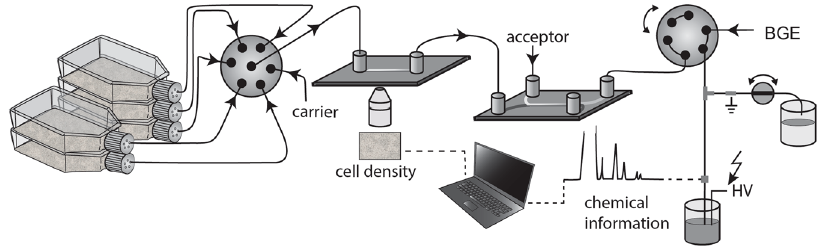
Figure 1. Schematic diagram of the experimental setup. Sample is sequentionally withdrawn from one of the five culture flasks, controlled by the selector valve. A carrier (5% methanol) is used to rinse to prevent cross contamination between samples. Digital imaging for cell density measurement is done using automated image analysis. The sample is then transported to a H-filter, where analytes are extracted into a cell-free solution, which is analysed by SI-CE with C4D. Fluidic isolation provided by the six port valve allows cell density measurement and extraction during the CE separation of the previous sample. With a run time of 12 minutes each flask is sampled once an